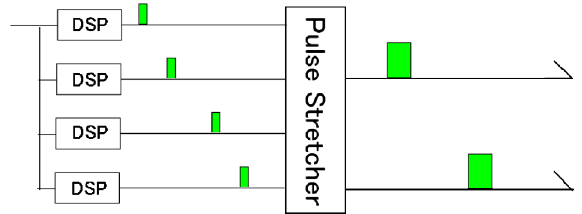
FIG. 37. Pulse stretcher generates set/reset pulse signals with widths that can be controlled by the separations of the input pulses.